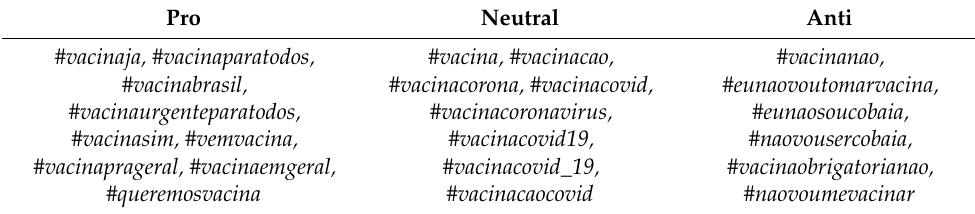
Figure 1. Workflow for public opinion analysis about the COVID-19 vaccination in Brazil. Table 1. Positional hashtags about the COVID-19 vaccination in